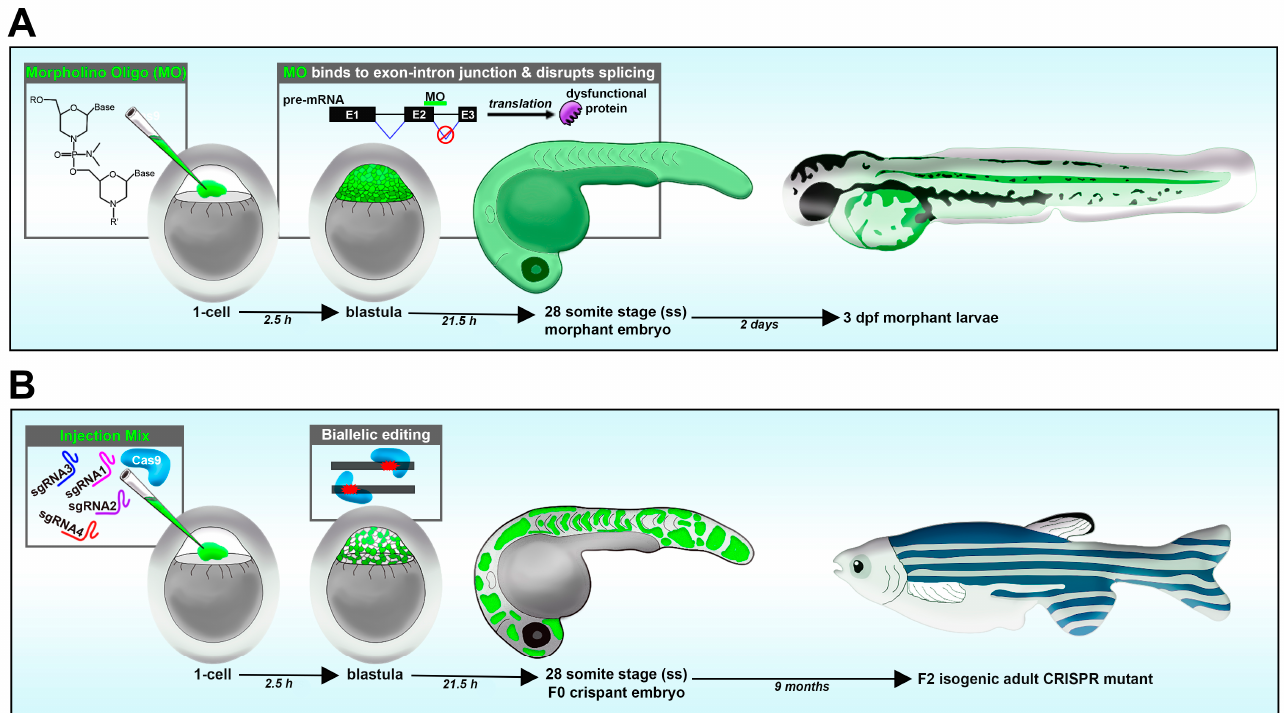
Figure 2. Reverse genetic loss-of-function strategies in the zebrafish embryo. ( A ) Morpholino knockdown. ( B ) CRISPR-Cas9.